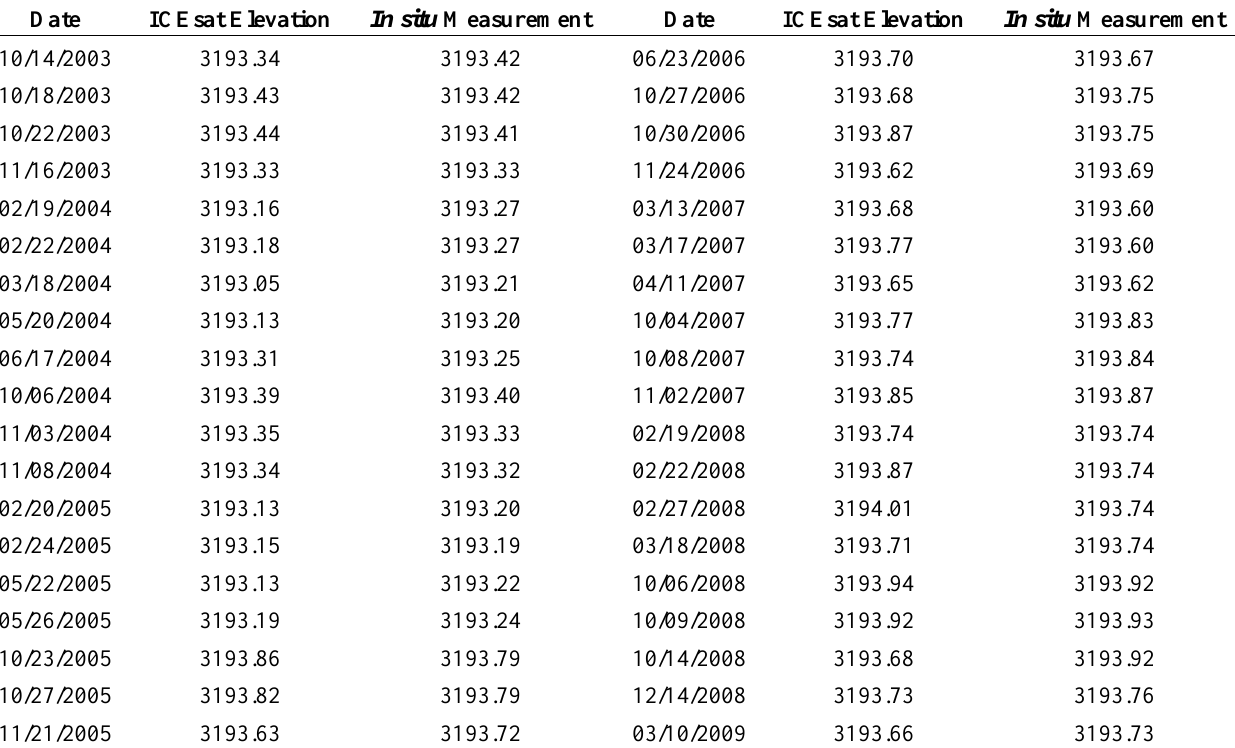
Table 1. Water level of Lake Qinghai derived from ICESat elevation data and the in situ measurements of water level at Xiashe station. The water level unit is in